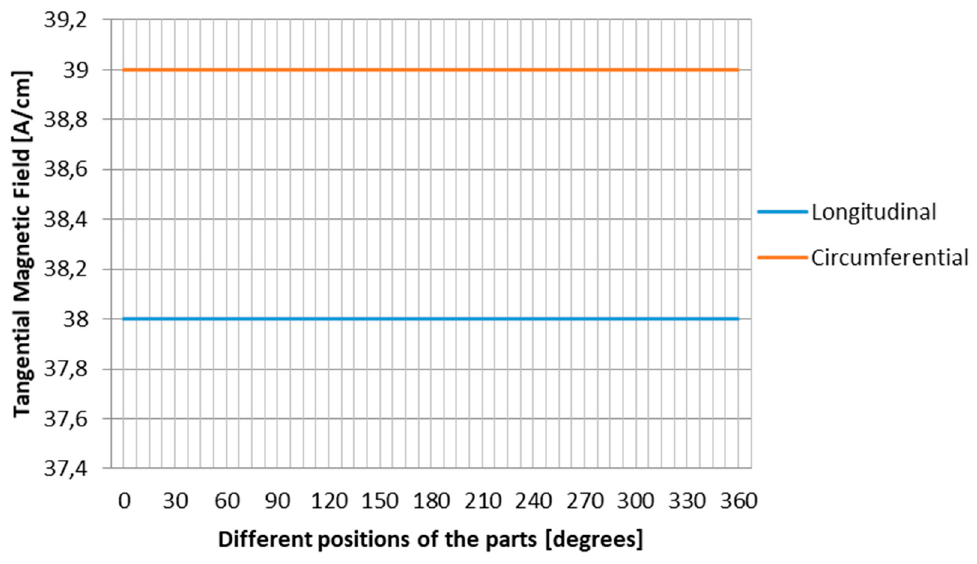
Figure 7. Tangential magnetic field parameters vs. different positions of the parts, measuring using an auxiliary device.